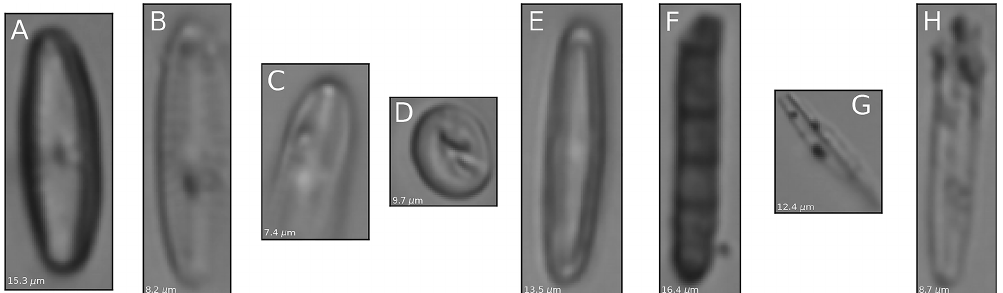
Figure 9. Diatoms identified in the Quelccaya Ice Core from the acquired FlowCam images. Particle D can be a Centrales diatom (possibly Cyclotella genus) or an algae. Particle F can possibly be a fungus. All other particles are Pennales diatoms. The particle diameters (ABD) are indicated in the bottom left corners. The presence of diatoms in this ice record has been previously reported, using SEM, by Fritz et al. (2015). A promising future application will be to naturally extend the model by incorporating additional training classes, including diatoms. At this stage, this has not been